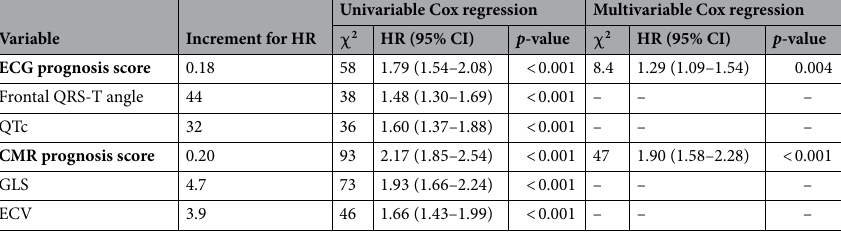
Figure 2 shows survival according to the ECG and CMR prognosis scores, respectively, and for patients with one normal but one increased score, or with both scores increased, using score probability greater than 50% as the cut-off. Figure 3 shows survival for the Aro ECG risk score (log-rank 15, p = 0.005), and the ECG (log-rank 64, p < 0.001) and CMR (log-rank 103, p < 0.001) prognosis scores, respectively, using score cut-offs at 25%, 50% and 75%.